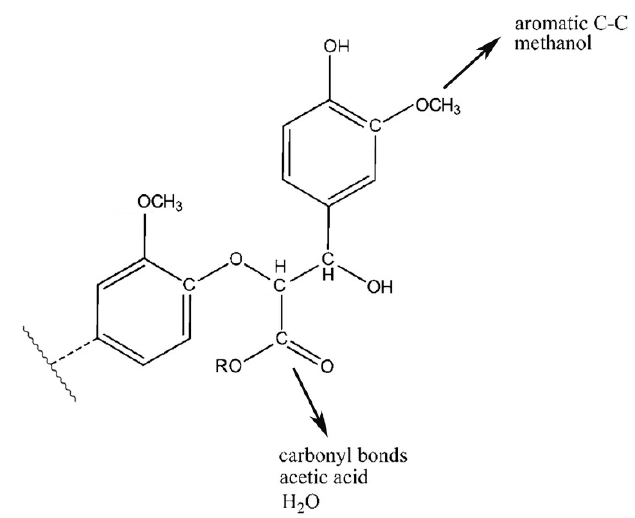
Figure 3. Possible pyrolysis pathway of primary decomposed functional groups in lignin during the pyrolysis.